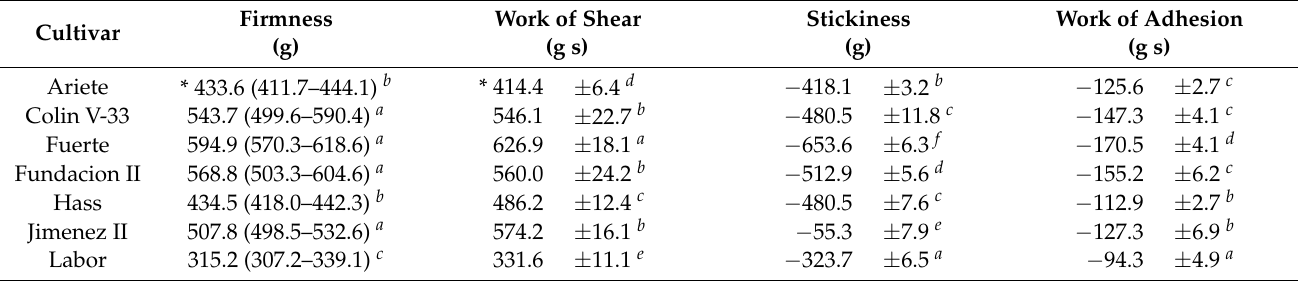
Figure 4. Principal component analysis (PCA) biplot of components F1 and F2, explaining 69% of the variance in the sensory descriptive profiles, proximate macronutrient composition, and instrumental texture analysis of the seven avocado cultivars. Avocado samples are shown in blue ( • ), while vectors for sensory descriptive attributes are shown in red ( (cid:4) ), and the descriptor names are shown in black. Variables were also classified with an abbreviation indicating if they were related to sensory flavor (F), sensory texture (T), sensory chemical sensation factor (C), proximate macronutrient composition (P), or instrumental texture analysis (I). Table 6. Instrumental texture parameters of seven commercial and no commercial avocado